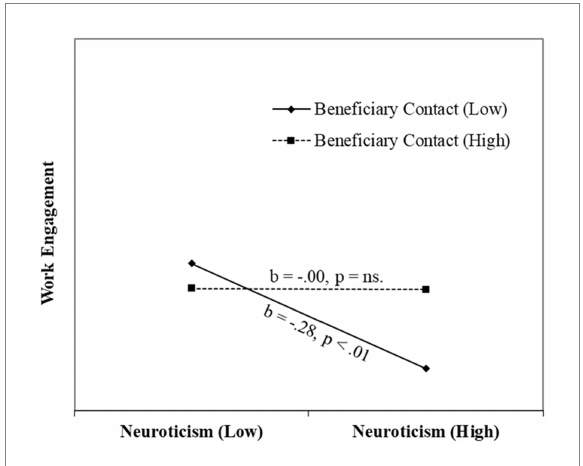
FIGURE 2 Interaction effect of beneficiary contact on Neuroticism–Work Engagement relationship.